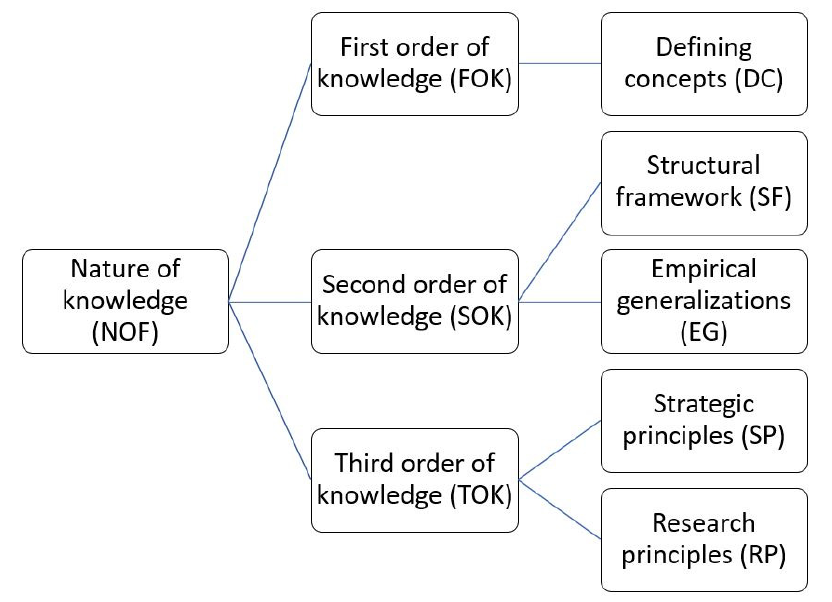
Figure 1. Nature of knowledge, based on Rossiter